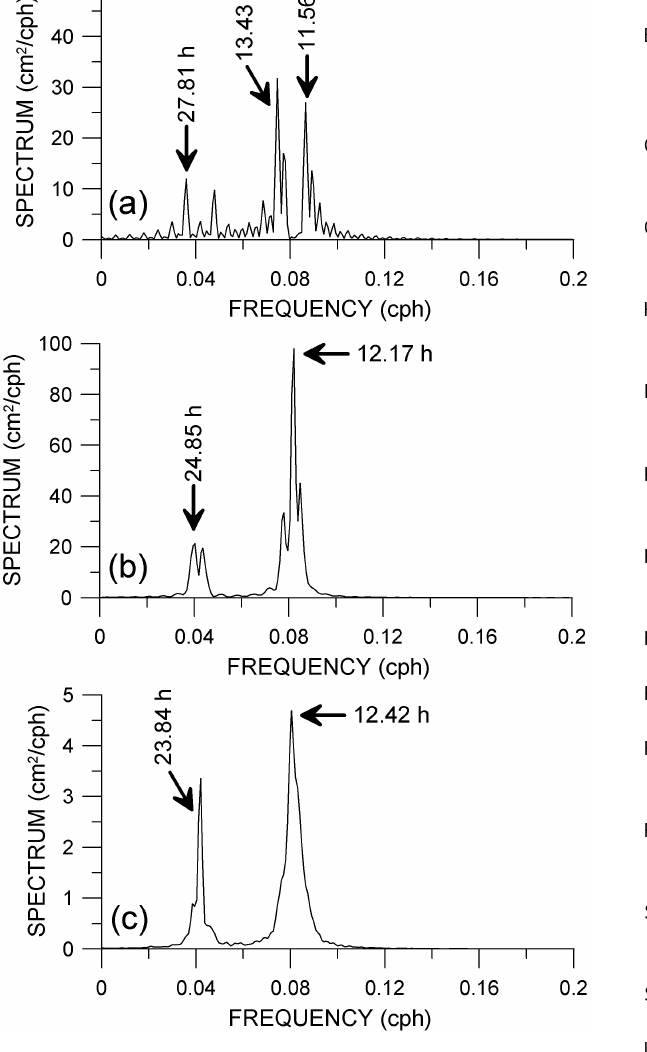
Fig. 9. Spectrum of the annual residual series computed from the simulated sea level series with (a) a time drift of 30min, (b) a time shift of 30min, and (c) a time drift randomly chosen for each artifi- cial chart (week) with values between –120 and